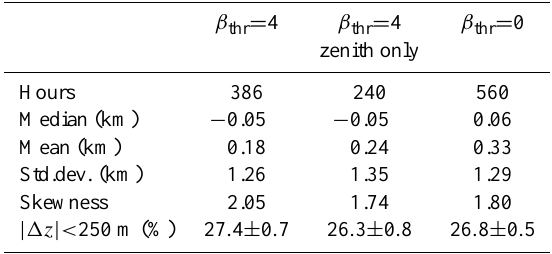
Table 4. Distribution of difference of lower boundaries of PMSE and NLC ( 1z bot = z bot , NLC − z bot , PMSE ), 1999–2008. β thr is